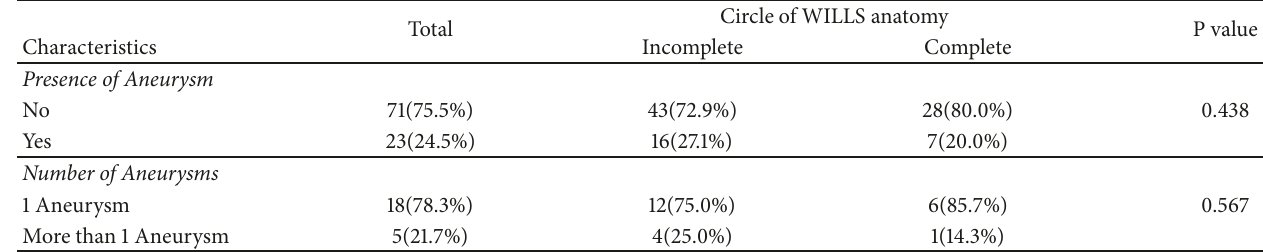
Table 5: Presence and number of aneurysms in complete and incomplete